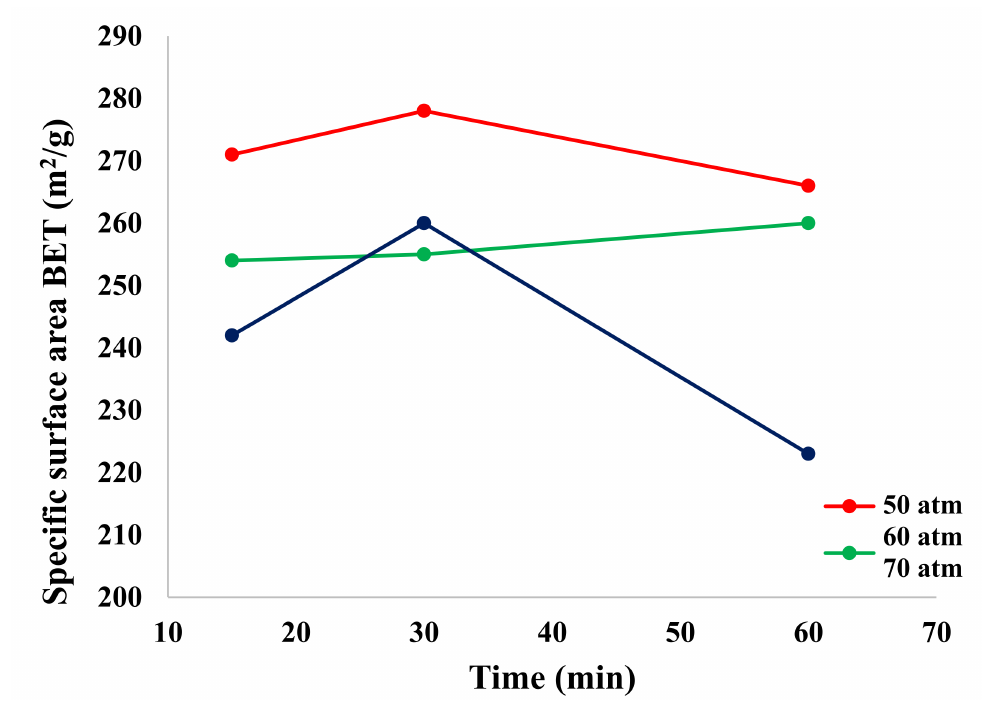
Figure 3. Dependence of the specific surface area as a function of process time and pressure. Figure 4 shows the dependence of density on pressure and process time. It can be observed that with an increase in these parameters (up to 30 min), the density increased, while after this time, it decreased.